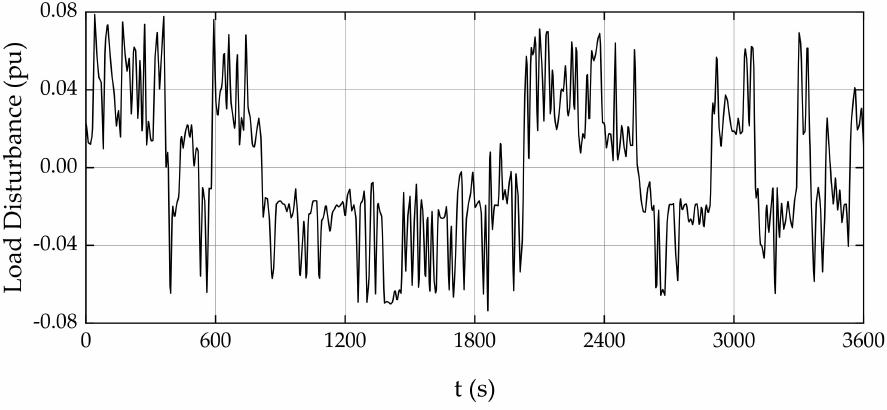
Figure 14. 60-min continuous load disturbance change curve.